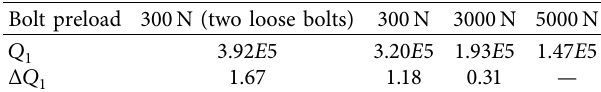
Table 9: Q and Δ Q under different bolt preload (impact ex- 1 1 periment of the connection structure with 6 bolts).